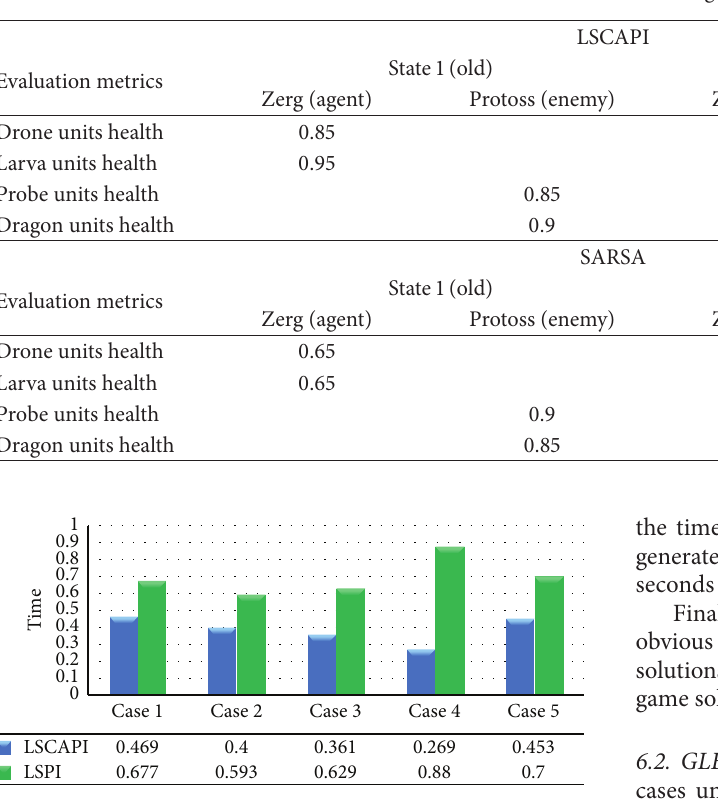
Figure 15: LSPI versus LSCAPI solution generating